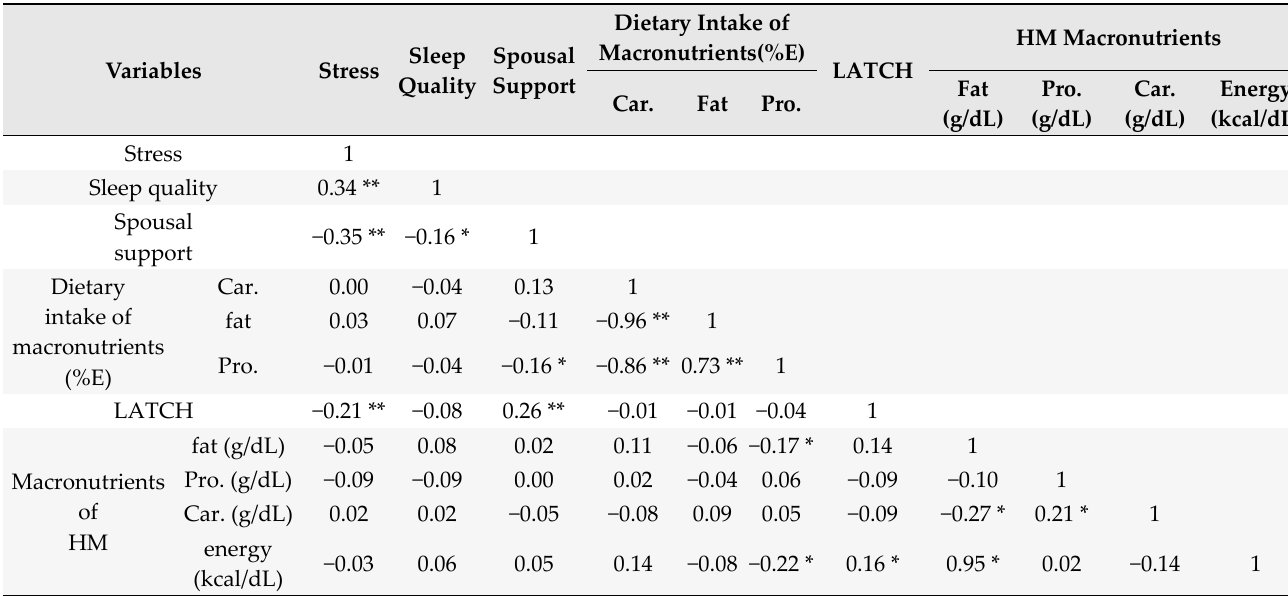
Table 3. Pearson’s correlation analysis of postpartum stress, sleep quality, spousal support, dietary Table 4. Effects of independent variables on HM energy ( n = 159). intake of macronutrients, breastfeeding assessment, and HM macronutrients and energy ( n = 159) . Table 4. Effects of independent variables on HM energy ( n = 159) .